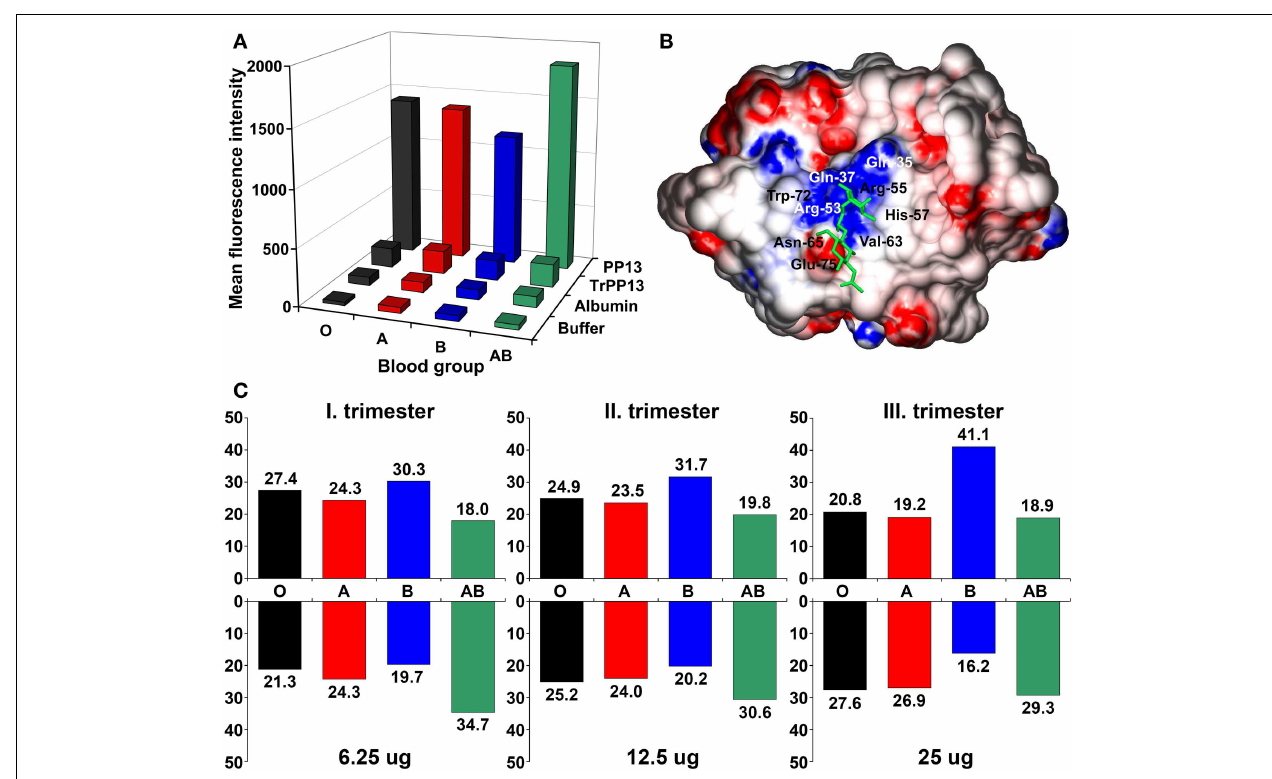
electrostatic potentials on the molecular surface, respectively.The binding groove of the CRD contains a central positive channel flanked by negative regions. (C) The relative binding of PP13 (lower panel) to different ABO blood group erythrocytes dynamically changed and inversely mirrored the relative serum PP13 concentrations (upper panel) in women with different ABO blood groups with advancing gestation from the first to third trimesters. All figures were published in Ref. (21). Kind permission for the reuse of figures was obtained from the Public Library of